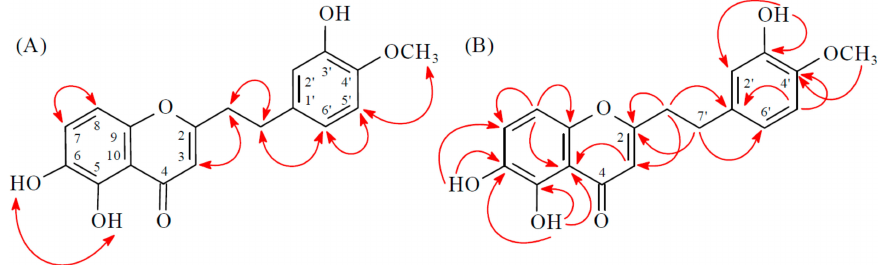
Figure 4. Key NOESY ( A ) and HMBC ( B ) correlations of 3